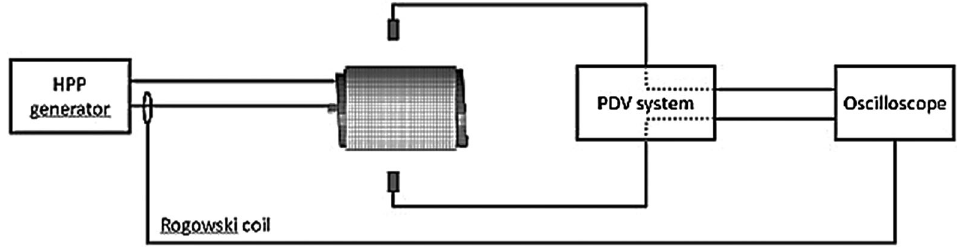
FIG. 3. Setup of expansion test for characterization of metals at high strain rates